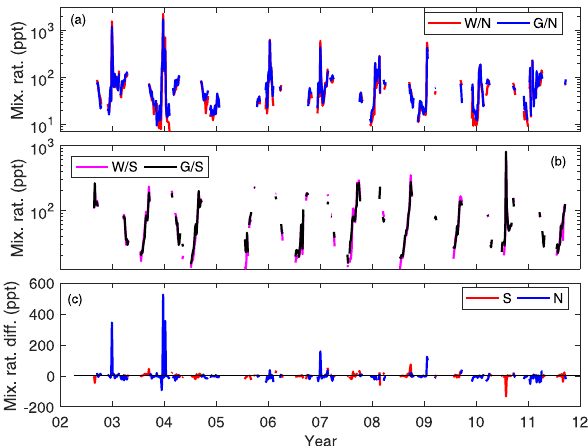
Figure 17. NO 3 mixing ratio 5-day time series at 3.7hPa from WACCM and GOMOS from 2002 to 2011 in the Arctic 60– 90 ◦ N (a) and in the Antarctic 60–90 ◦ S (b) . The colour coding symbols: W/S and W/N are WACCM in Antarctic, Arctic; G/S and G/N are GOMOS in Antarctic, Arctic. In the both panels the y axis is logarithmic. In (c) the mixing ratio difference is shown for the Arctic and the Antarctic in the mixing ratio unit. The colour coding symbols: S is Antarctic, N is Arctic.